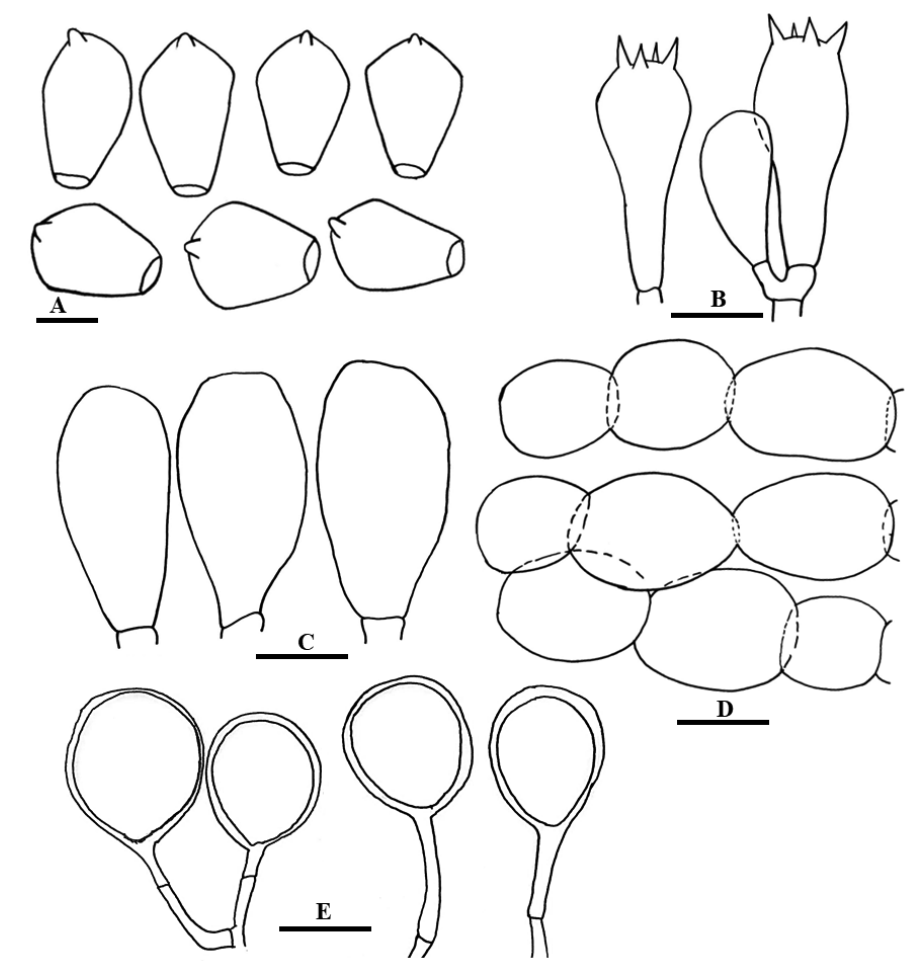
Figure 4. Line drawing of anatomical characters of Coprinellus campanulatus A Basidiospores B Basidia C Cheilocystidia D Pileipellis E Veil elements. Scale bars: 10 µm ( A ), 20 µm ( B–E ).